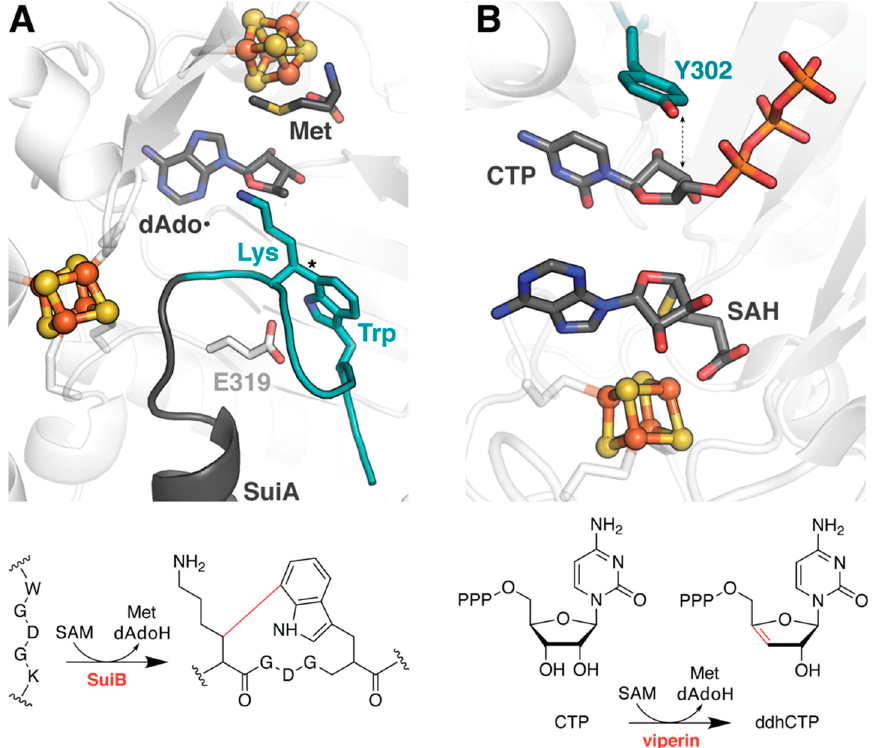
Figure 3. Docking studies help to identify catalytic residues in both SuiB and viperin. ( A ) SuiB catalyzes a C–C crosslink, marked with an asterisk in the structure, to cyclize the core region of a ribosomally synthesized peptide, SuiA. Docking methods were used to simulate the portion of the peptide that was disordered in the crystal structure (PDB accession code: 5V1Q), shown in teal. The putative active site base, E319, is drawn in stick representation. ( B ) Together, docking and MD studies have helped to elucidate the function of viperin (PDB accession code: 6Q2P) and support a PCET role for a conserved active site Tyr.